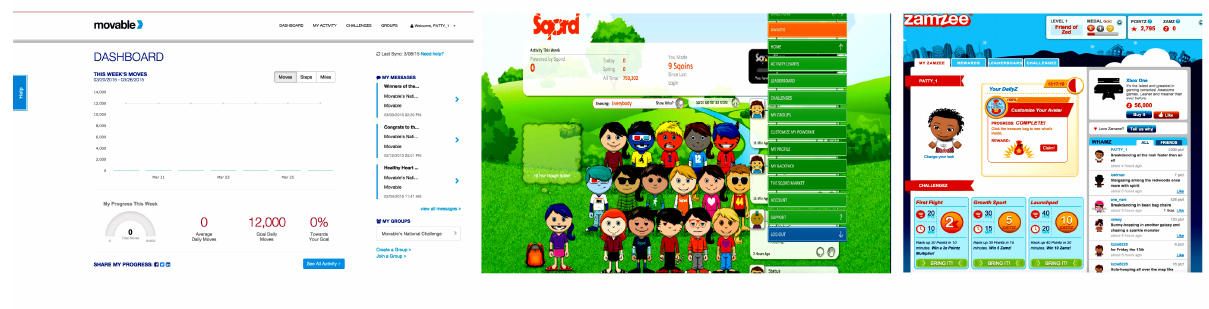
Figure 2. The home pages of the MovBand (MB), Sqord (SQ), and Zamzee (ZZ)